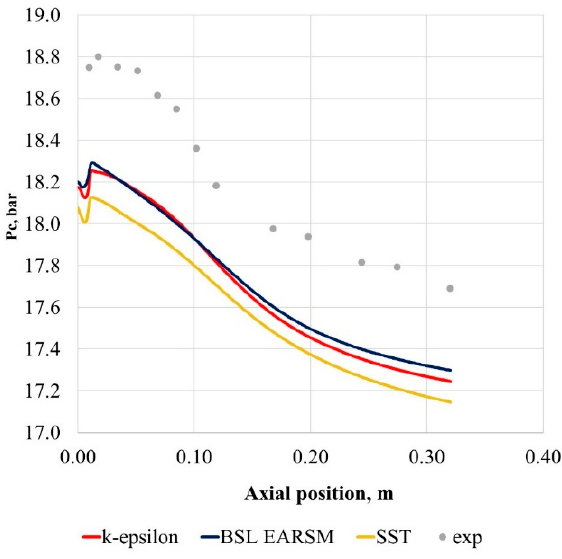
Figure 24. Absolute pressure distribution.